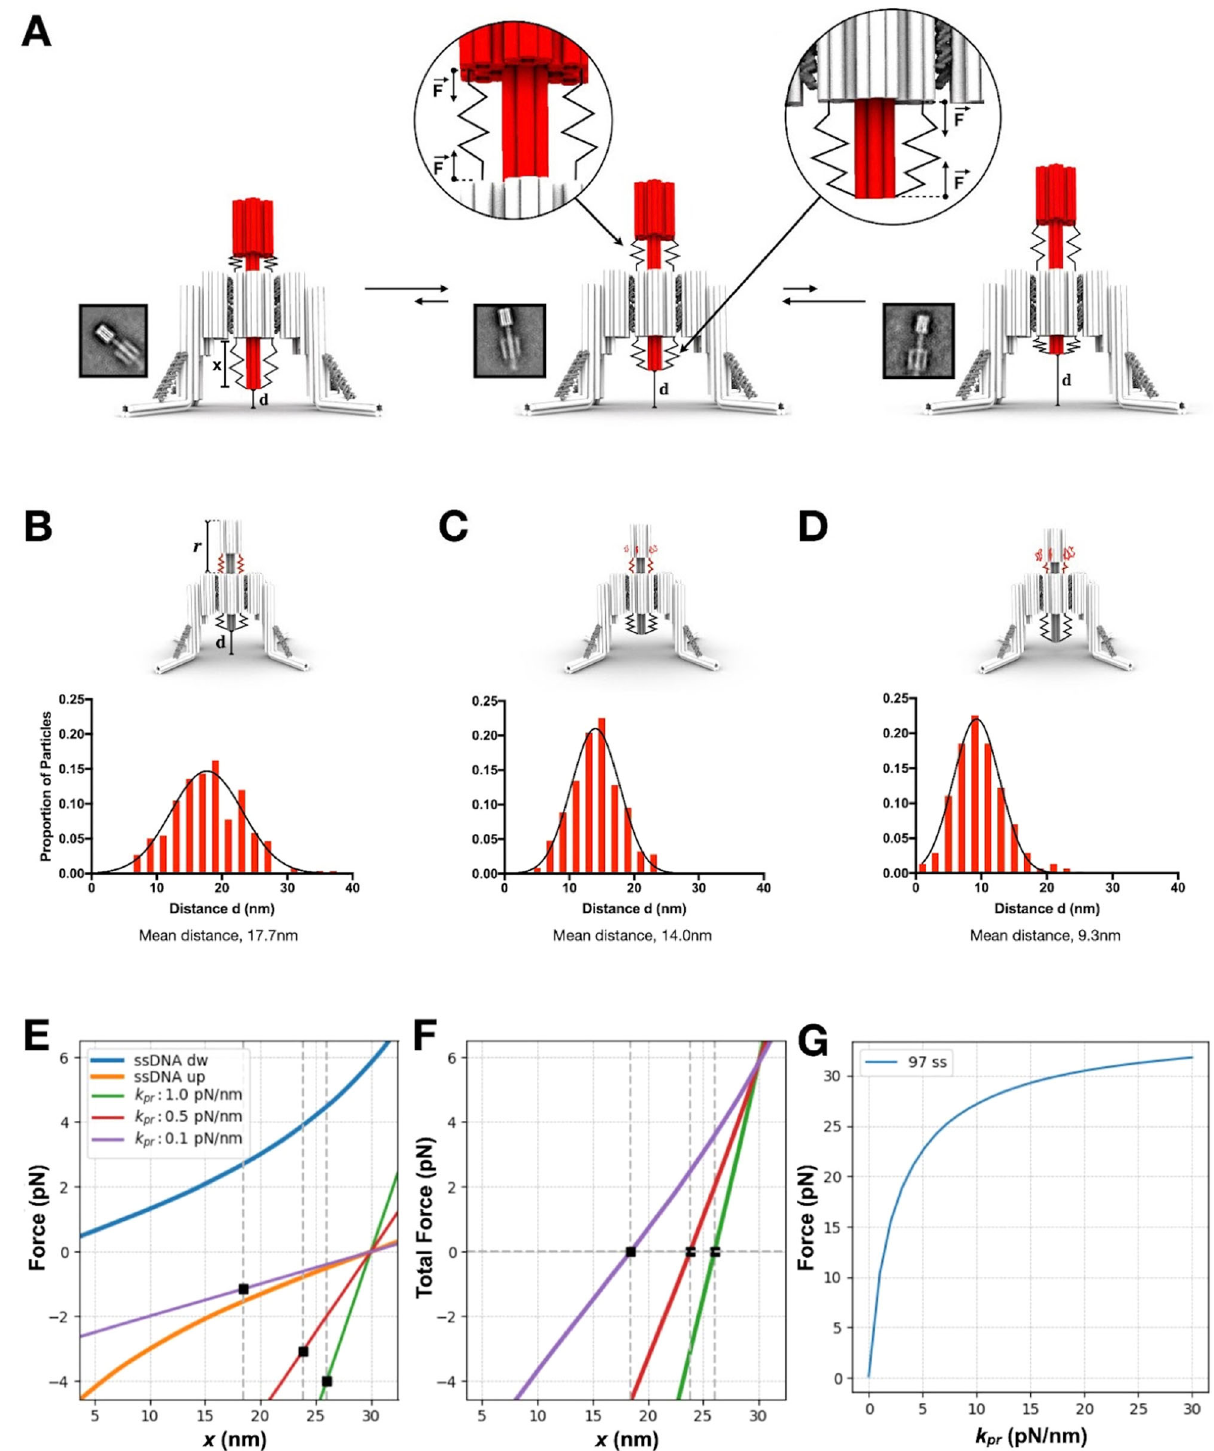
fl uctuations on the Nano-winch and protein and with salt concentrations matching those of folding conditions to retain structural integrity. Simulations indicated a tension in a range similar to the WLC model. An estimate of the force exerted on the linear spring as a function of k protein is given in Supplementary Fig. 25. Force generated by the entropic spring behavior of the connectors in the autonomous mode is translated through the highly rigid body 12 of the Nano-winch to the target molecule at the tip of the piston. As the piston exerts